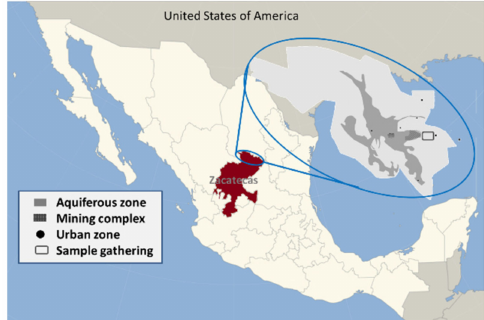
Figure 1. Localization of natural sources of